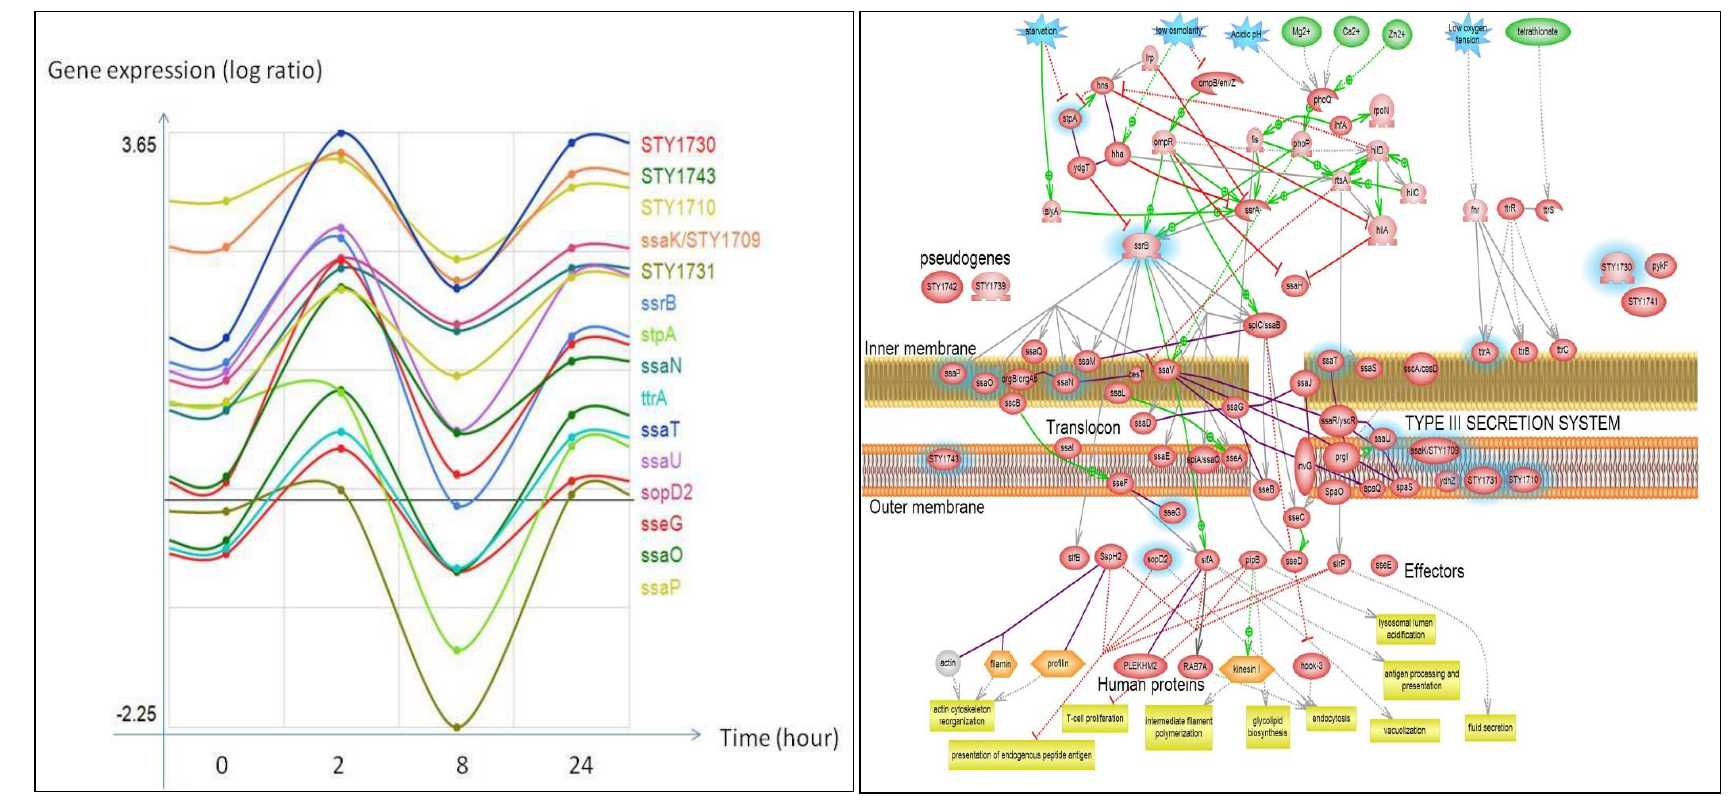
Figure 12a: Cluster 2A. SPI-2 genes form two distinct gene expression clusters during the time-course of Salmonella infection of macrophages. This cluster of genes showed positive correlation during the systemic infection (left). The expression profile corresponds to the proteins highlighted in blue. It can be seen that the main regulator is ssrB and most of the translocon, type III secretion system and effector genes have the similar profile (right). Expression profile graph of cluster 2A shows that the main environmental stimulus is starvation which is sensed by stpA and slyA . The signal is then transmitted to ssrB , the main regulator in cluster 2A. SlyA was also found a significant regulator by sub-network enrichment analysis after 2 hours of infection. Note the temporary down-regulation of entire cluster at 8 hours of infection. This can be explained by the switch in ssrAB control. Initially it may be activated by slyA in response to starvation and later in the infection s srAB expression can be controlled by either stpA and or lrp global regulators that are also respond to